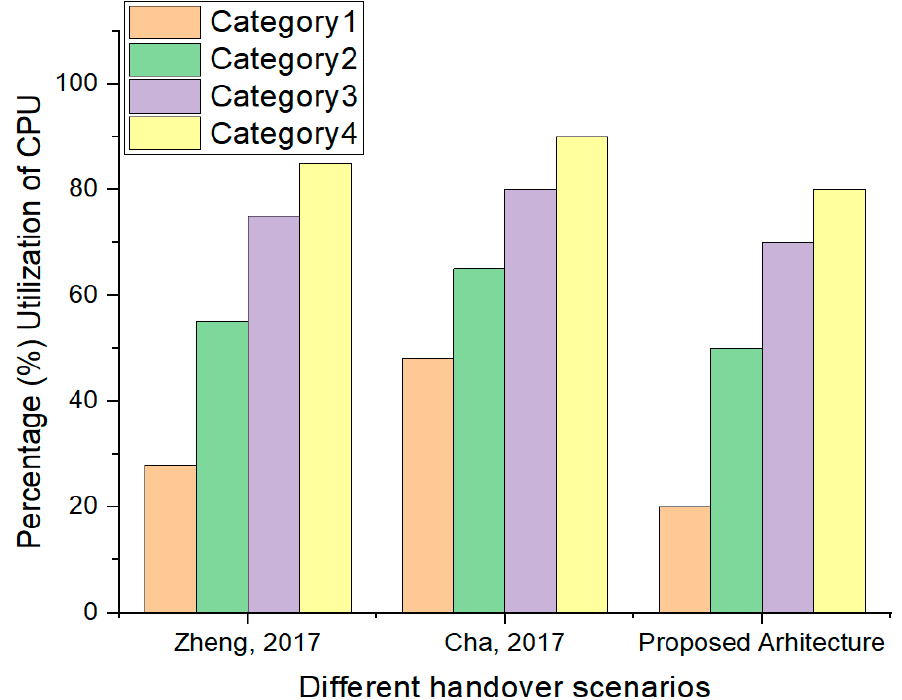
Figure 9. Comparison of CPU usages of proposed method with existing studies (Zheng, 2017), and (Cha, 2017) illustrated in [25,26].